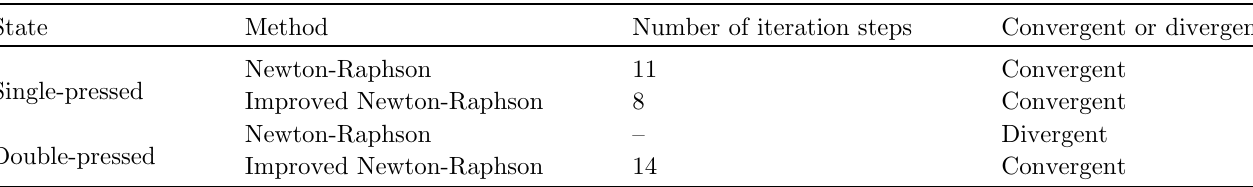
Table 3. It can provide a reference for future scholars to supplement the numerical model.